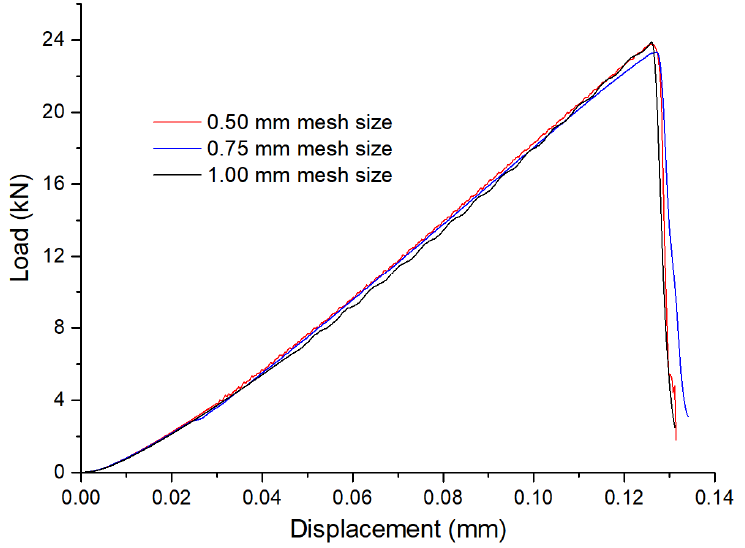
Figure A2. The influence of mesh size on the loading curve for the Type II Brazilian testing.